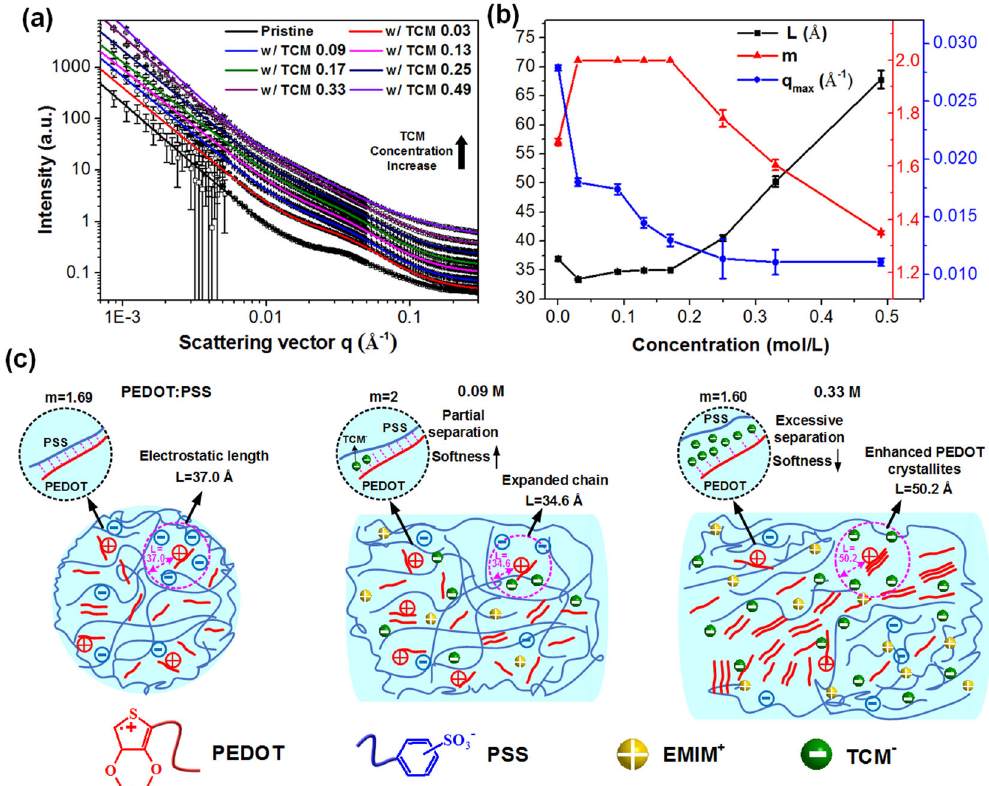
Fig. 3 Solution microstructure of PEDOT:PSS solution. a SANS results of PEDOT:PSS hybrid solutions as a function of the EMIM:TCM content, with deuterated water as the solvent. Hollow dots with error bar denote raw data and solid lines denote the fi tted data with an empirical model. The error bars of the SANS curves are attributed to the intensity variation of the 2D scattering pattern during radial integration. b The extracted fi tting parameter, indicating the structural change of PEDOT:PSS hybrid as a function of the EMIM:TCM content. Error bars indicate standard deviations. Note: some error bars are smaller than the plotting symbols. c Schematic illustration of the supramolecular assembly of PEDOT:PSS/EMIM:TCM hybrid in aqueous solution.